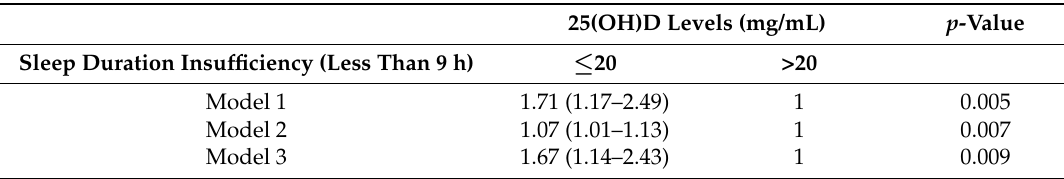
Table 3. Odds ratio (OR) and 95% confidence interval (CI) for insufficient sleep (<9 h/day) by categories of 25(OH)D levels ( n =